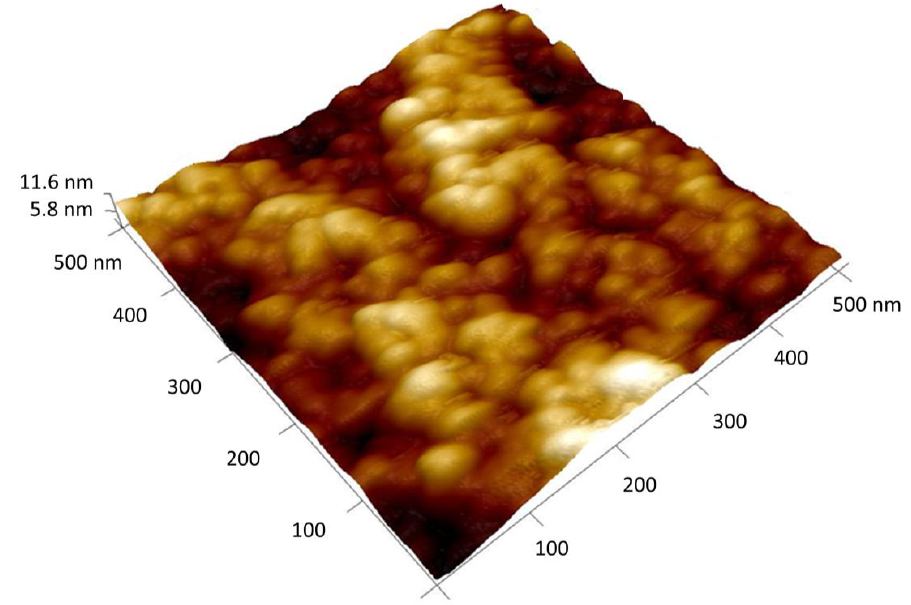
Figure 6. Three dimensional AFM image under 50 V with an exposure duration of 1200 s (500 × 500 nm 2 ).